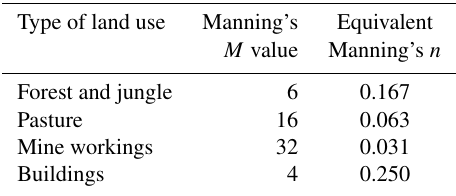
Table 1. Manning’s M roughness values used in the mudflow